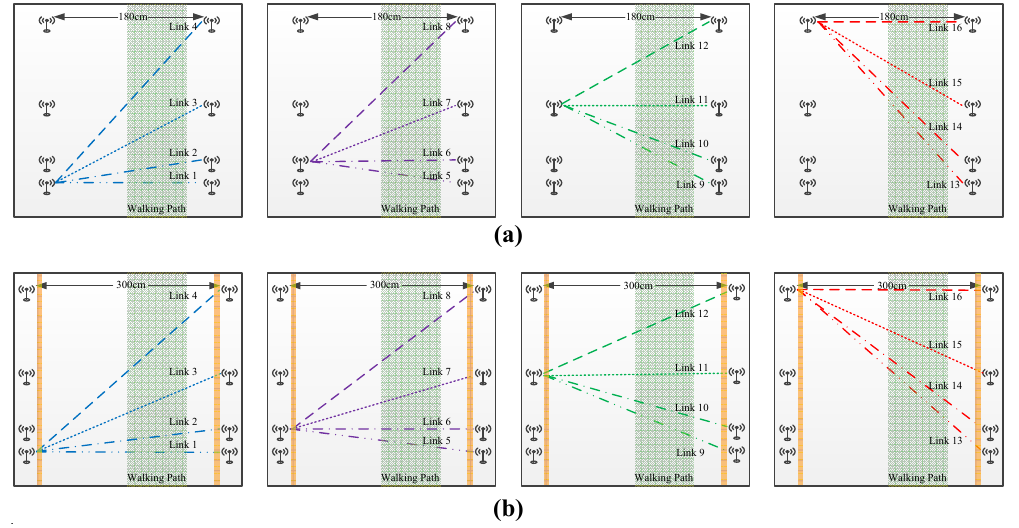
Figure 2. Geography map and link label of each sensing layer. ( a ) LOS scenario; ( b ) NLOS